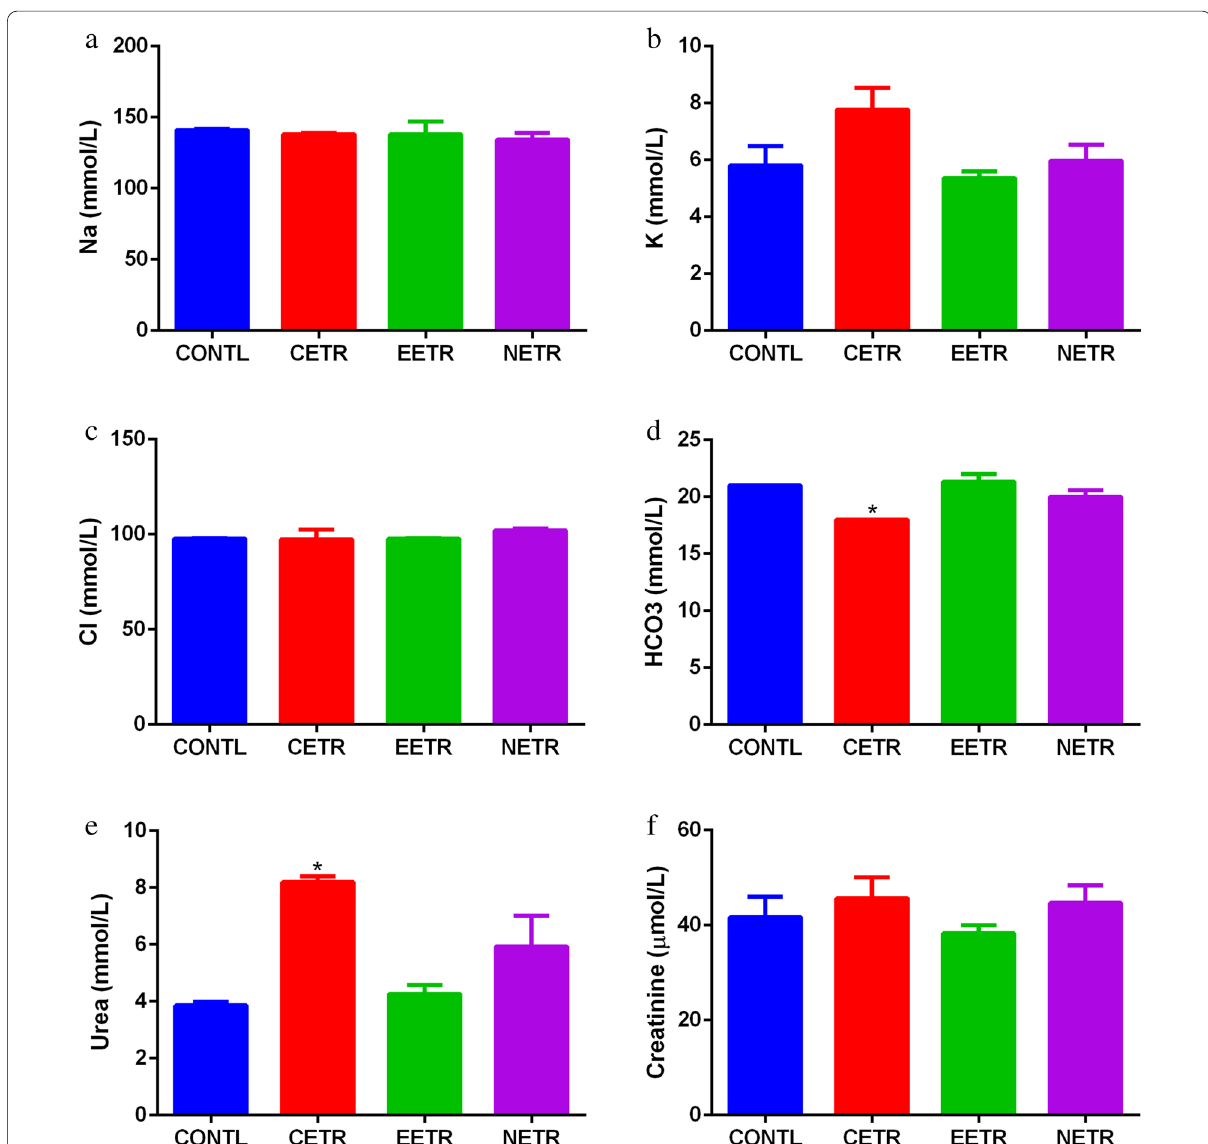
Fig. 2 Serum levels of creatinine 14 days after single dose exposure of the rats to different extracts of Bombax costatum . a Na, b K, c Cl, d HCO3, e Urea and f